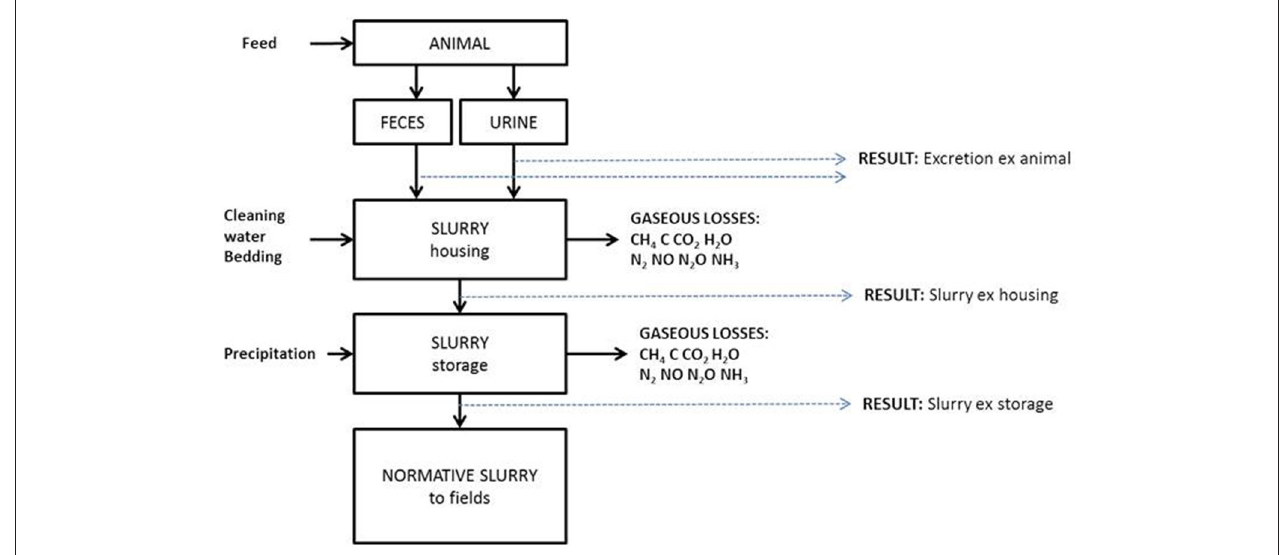
FIGURE 2 | Flow chart of the mass balance calculation of slurry as calculated in the Finnish Normative Manure System. The additions and gaseous losses are named, other components (esp. P, K) are assumed to remain in the manure. Separately collected urine follows the same principle, while solid manure types (deep litter, farmyard manure, separately collected dung) do not receive cleaning water, but may receive feces from outdoor yards (see: flow charts per manure type in Luostarinen Luostarinen et al., 2017a).